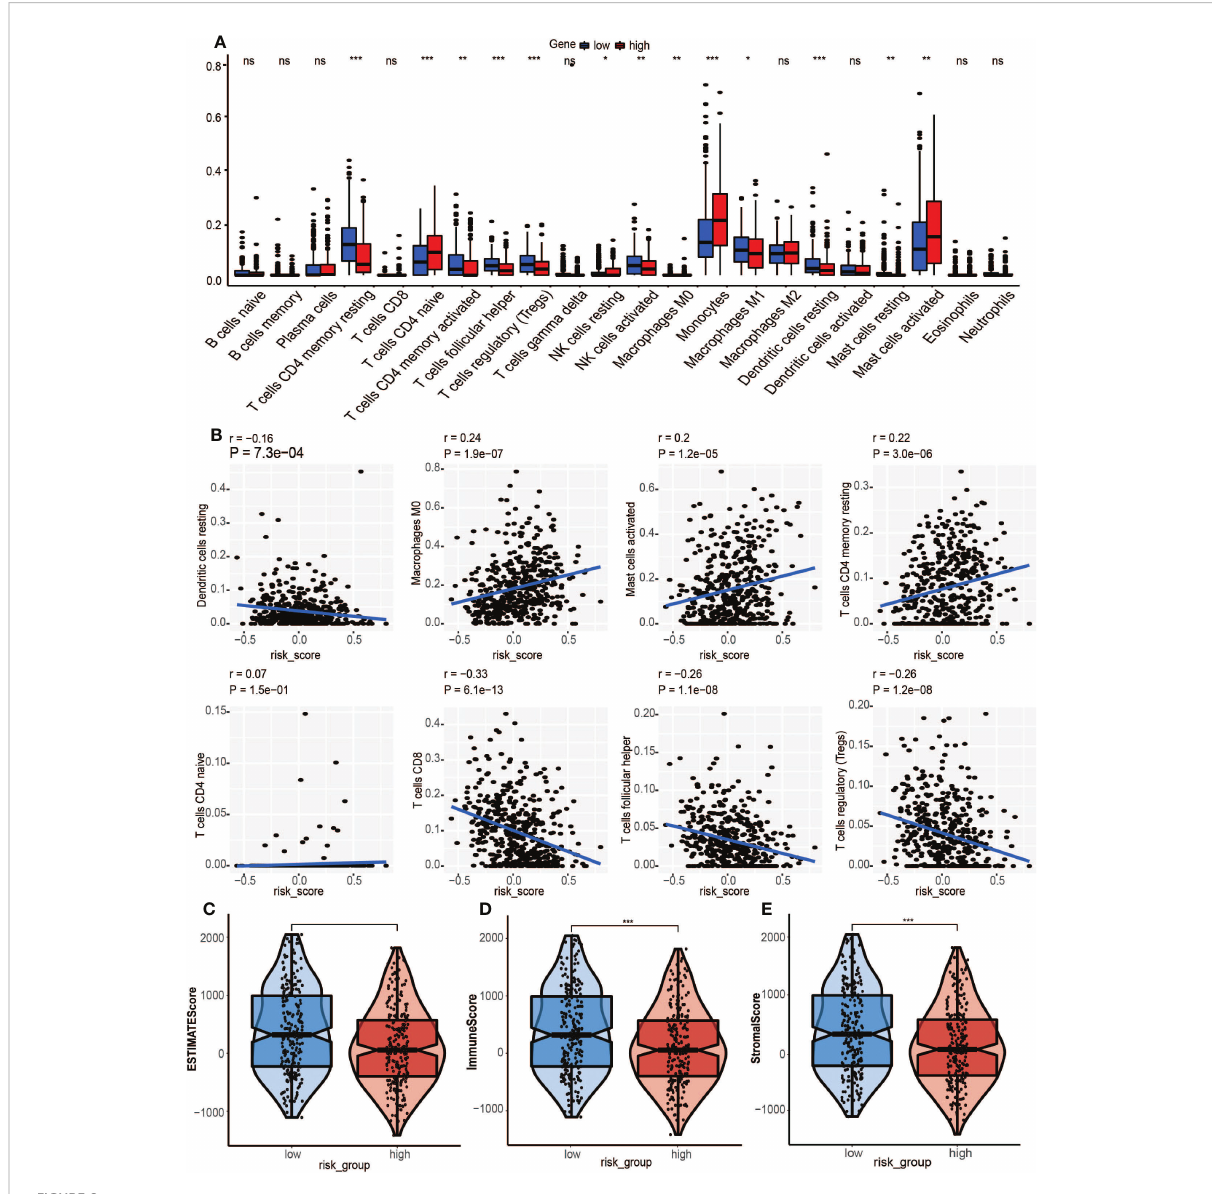
FIGURE 8 Association between tumor immunity and GRGPI scores in high and low GRGPI groups. (A) The 22 in fi ltrating immune cells are shown in boxplots. (B) Correlation analysis between 8 types of in fi ltrating immune cells and GRGPI scores. (C – E) Boxplots showing the correlation between GRGPI with ESTIMATE, immune, and stroma scores of HNSCC samples. (ns, not signi fi cant, *p < 0.05, **p < 0.01, ***p <